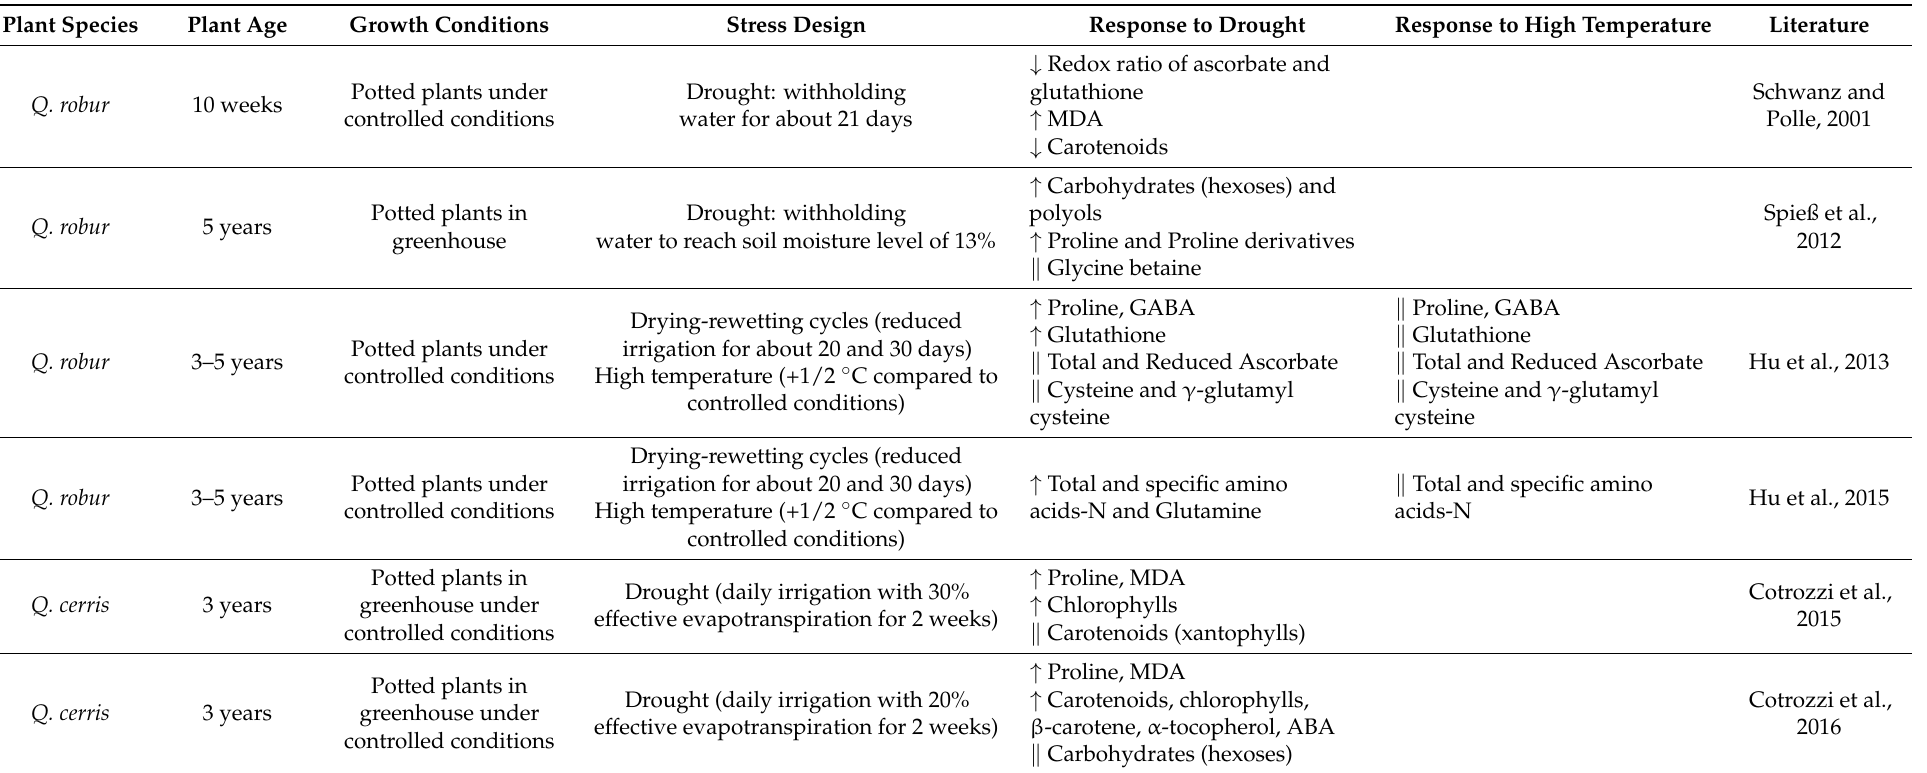
Table 1. Responses to different biochemical components of the plant defense system to single drought or high temperature stress in young trees of Q. robur and Q. cerris